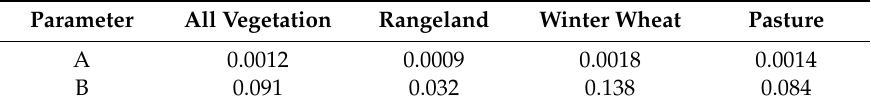
Table 3. Empirical parameters of the water cloud